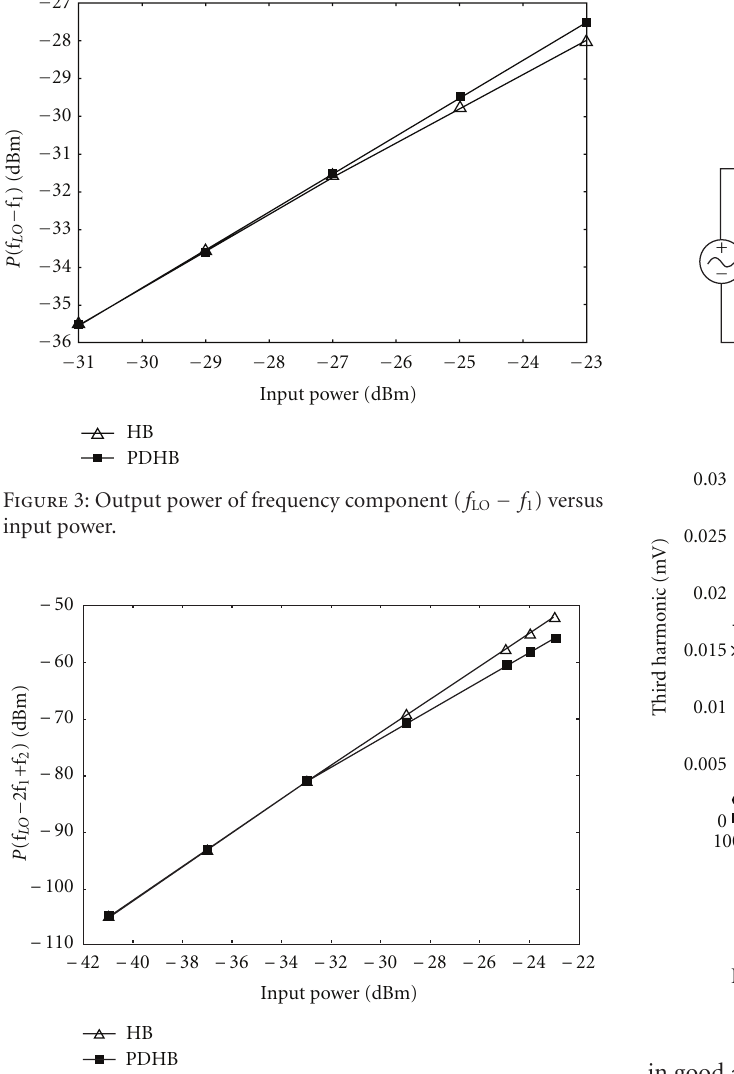
Figure 4: Output power of frequency component ( f LO − 2 f 1 + f 2 ) versus input power.